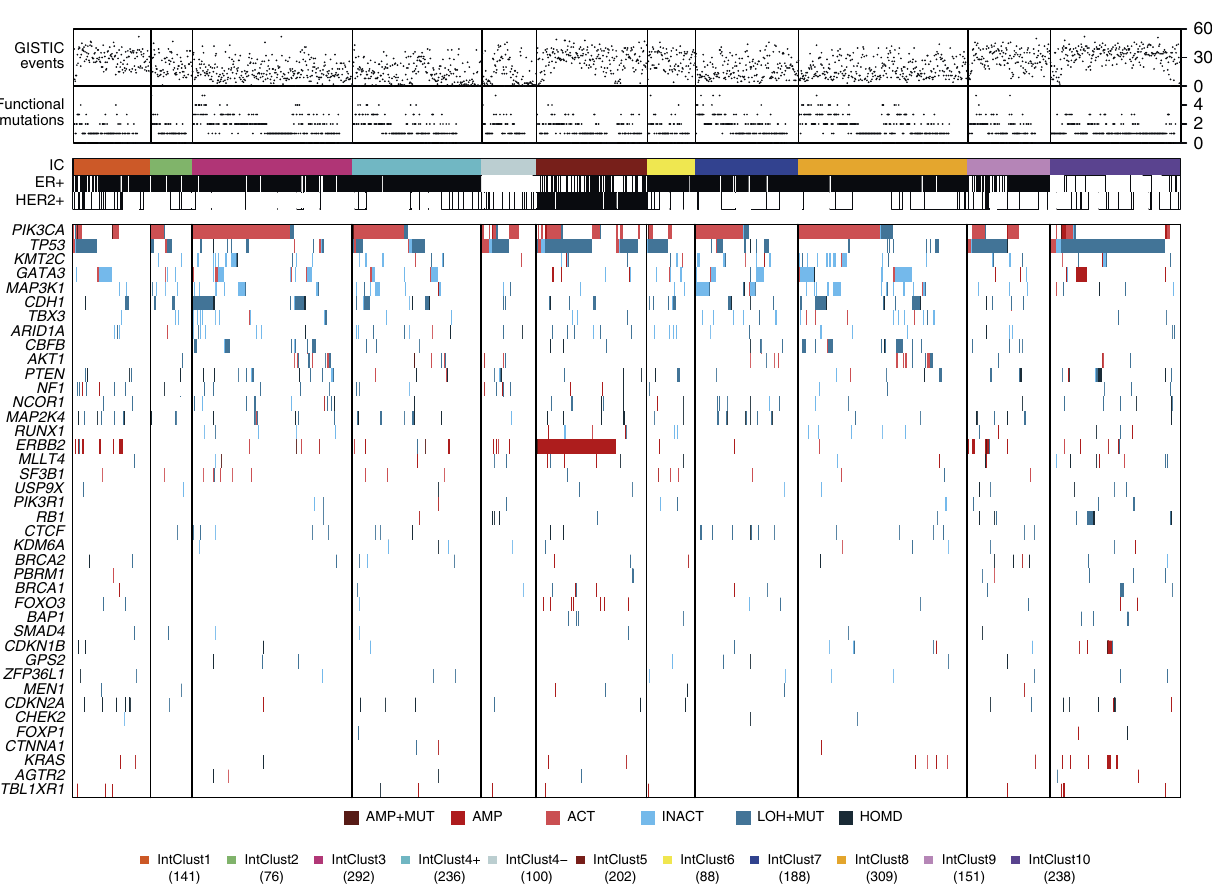
(Fig. 6a, Supplementary Table 5) for ER þ and ER (cid:3) tumours